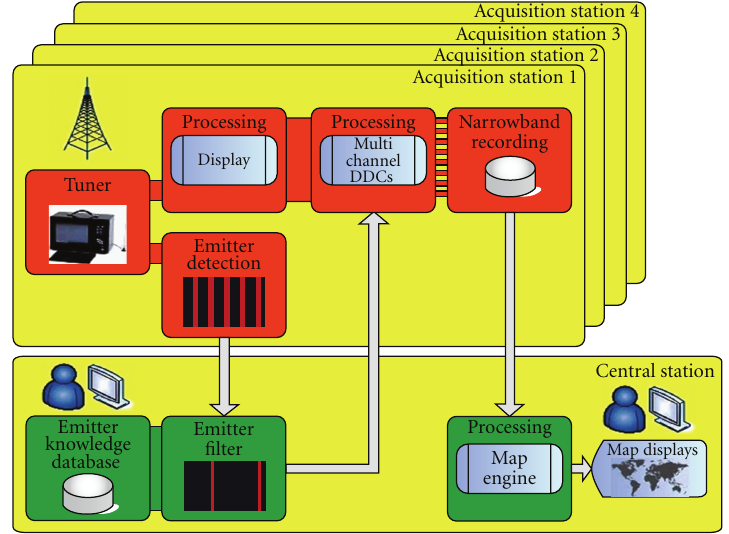
Figure 8: Multisensor setup of the new radio surveillance system developed by MEDAV.